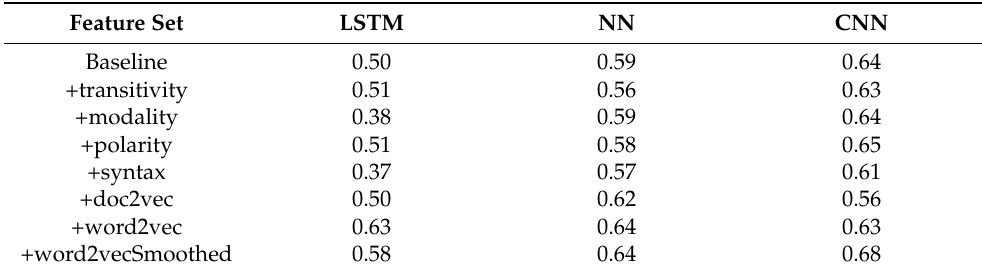
Table 8. Classification of solutions from non-solutions using deep learning networks by 5-fold